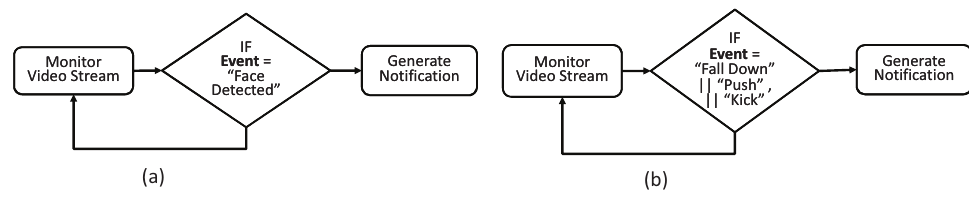
Figure 18. Anomaly detection rules. ( a ) show rules for event type “Face Detection”, i.e., when a face in a video stream is detected, then a notification is generated. Similarly, ( b ) show anomalies detection rules for abnormal events, i.e., when an abnormal event like Fall Down, Push, or Kick is detected in a video stream, then a notification is generated accordingly.